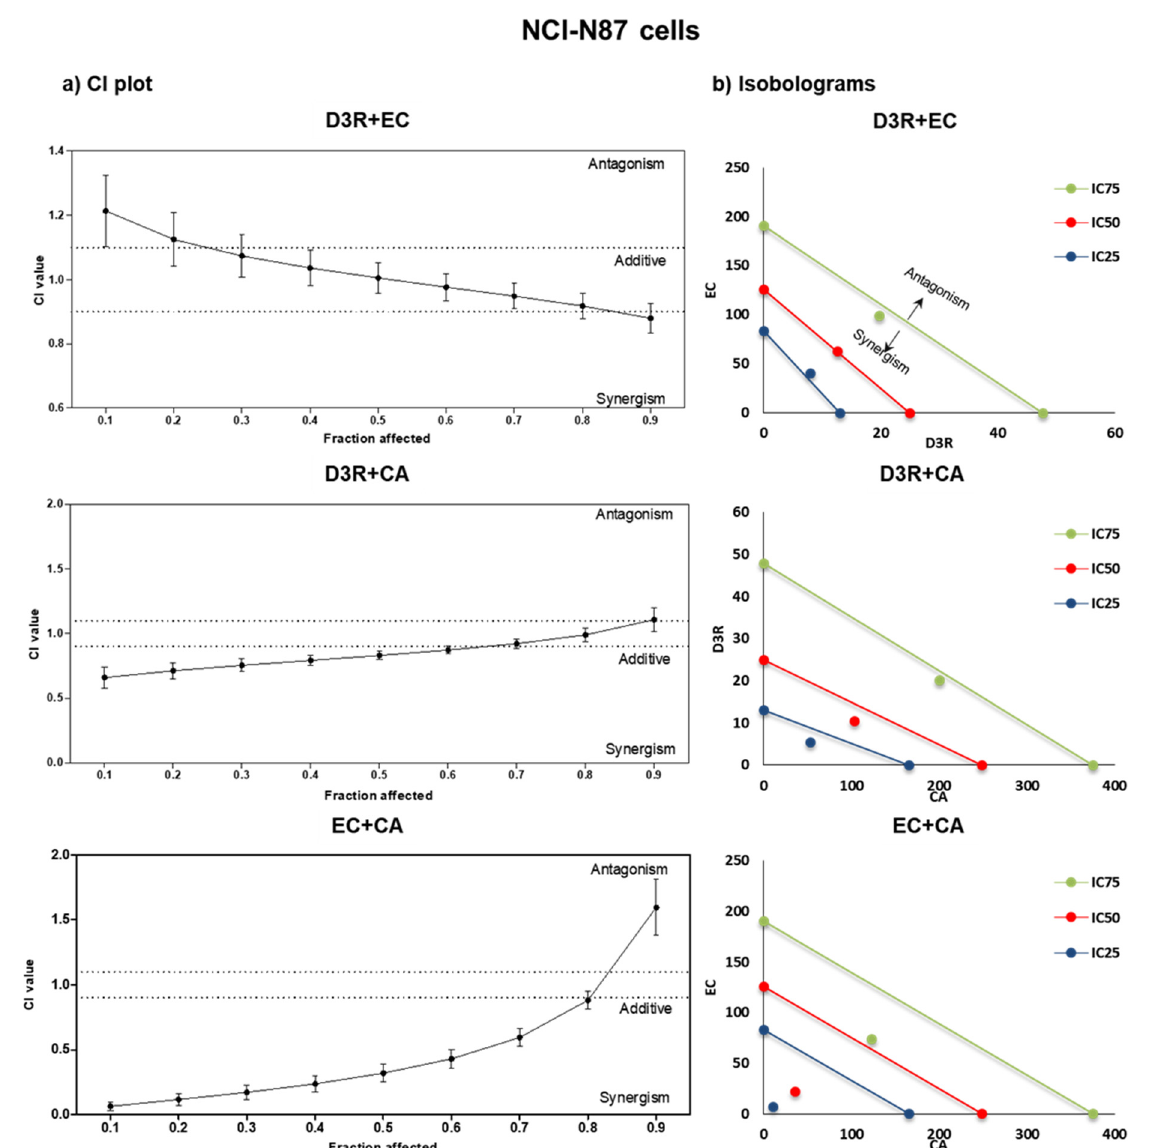
Figure 2. CI-plots ( a ) and isobolograms ( b ) of D3R, CA, and EC binary combinations: EC+D3R, CA+D3R, and CA+EC after exposure on NCI-N87 cells. The CI values were obtained from three independent experiments (quadruplicates); the vertical bars on CI-plots indicate 95% confidence intervals for CI values based on sequential deletion analysis [19] .